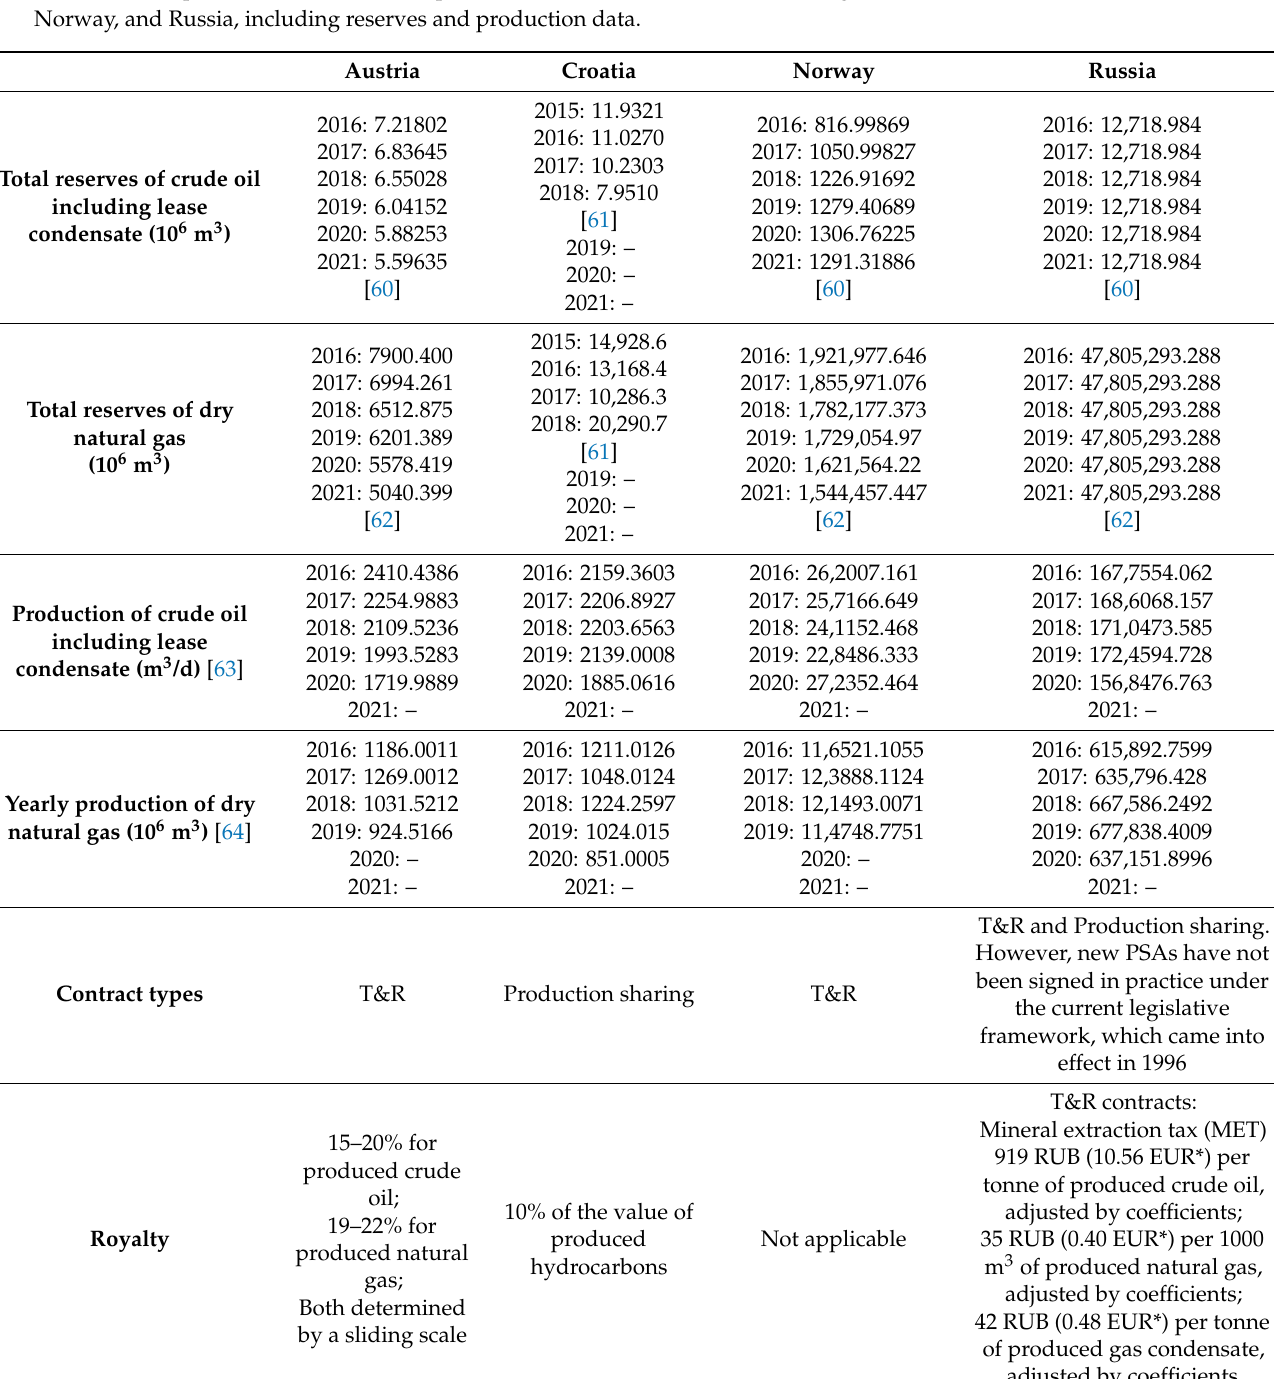
Table 6. A comprehensive review of comparisons of the fiscal, institutional, and legislative frameworks of Austria, Croatia, Norway, and Russia, including reserves and production